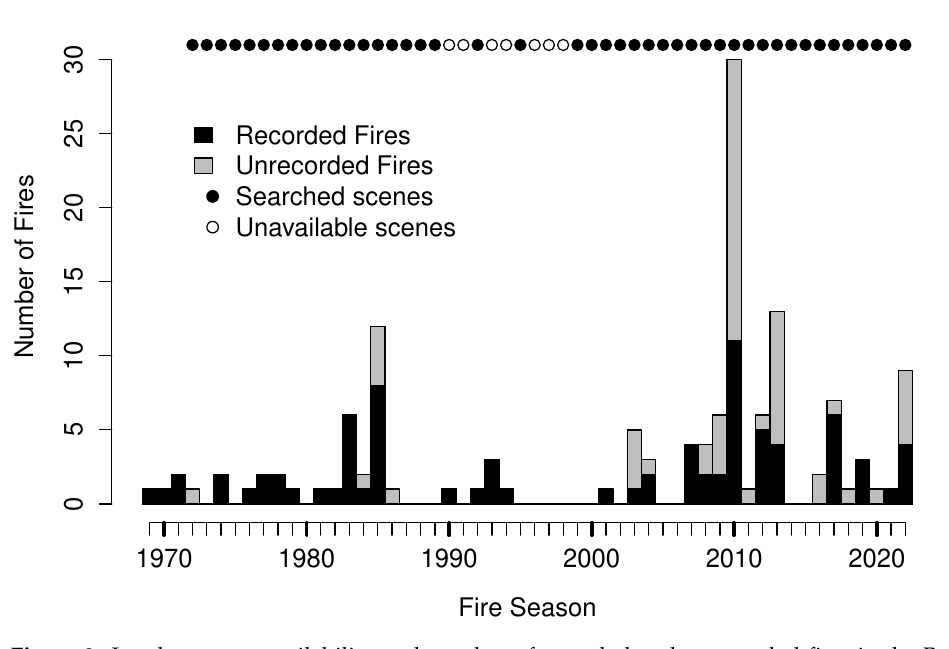
Figure 3. Landsat scene availability and number of recorded and unrecorded fires in the Brooks Range Foothills ecoregion.